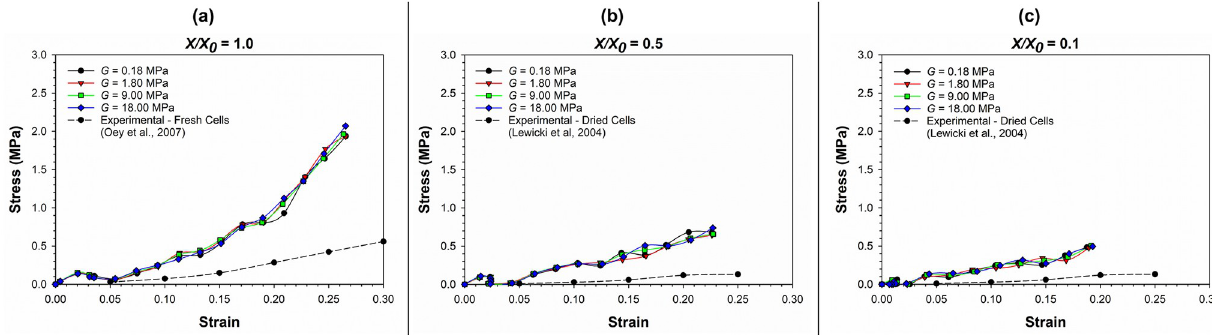
Fig 15. The stress-strain relationship of cells as affected by different cell wall compressive modulus ( G ) values. (a) fresh cells ( X/X 0 = 1.0); (b) moderately dried cells ( X/X = 0.5); (c) extremely dried cells ( X/X 0